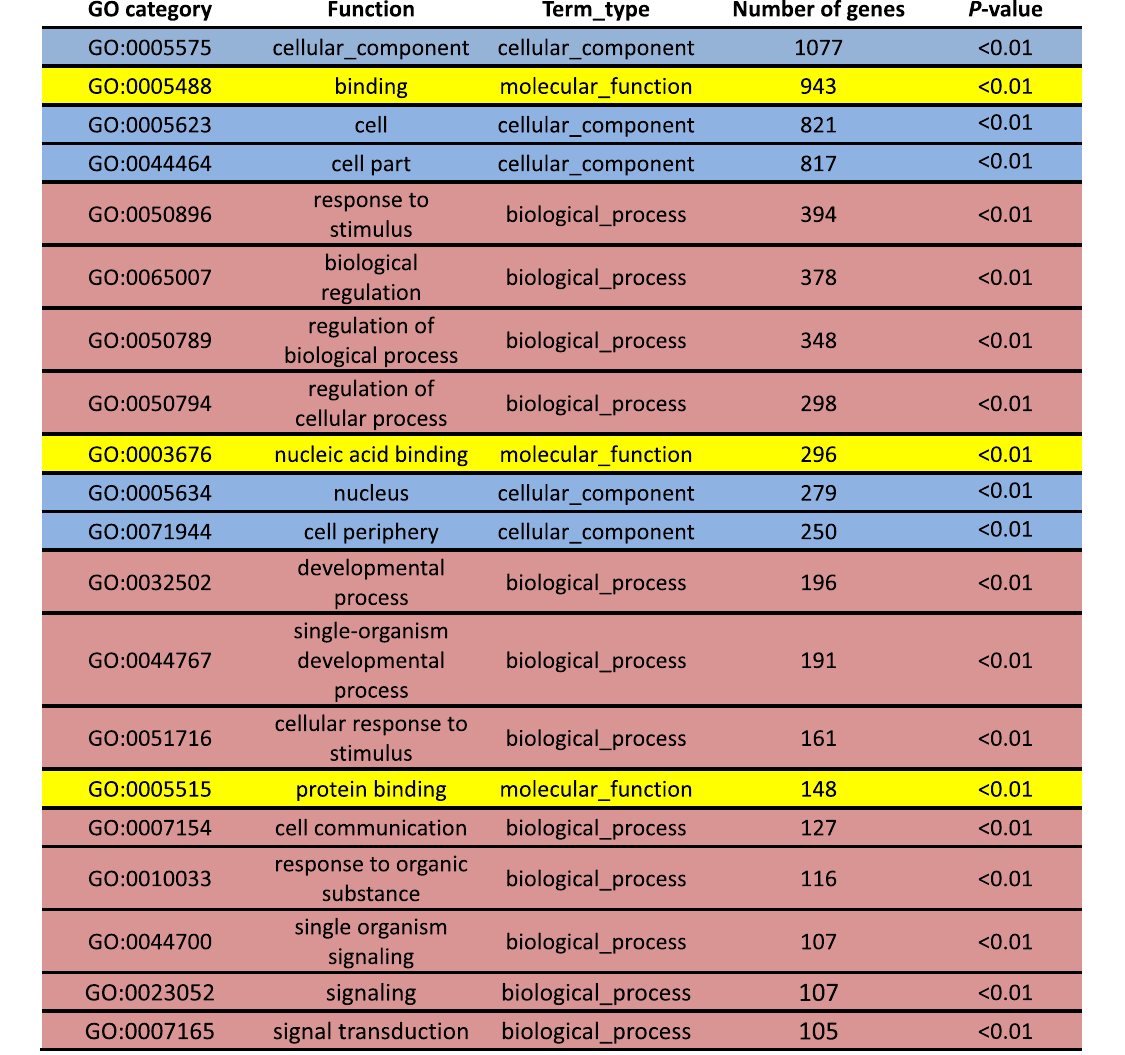
Table 2 Gene ontology (GO) classification of differentially expressed genes (DEGs) derived from the ‘ Wp+R vs. Wp ’ comparison. Wp + R, Rhizoglomus intraradices -inoculated wild rice infected with Magnaporthe oryzae ; Wp, R. intraradices -uninoculated wild rice infected with M.